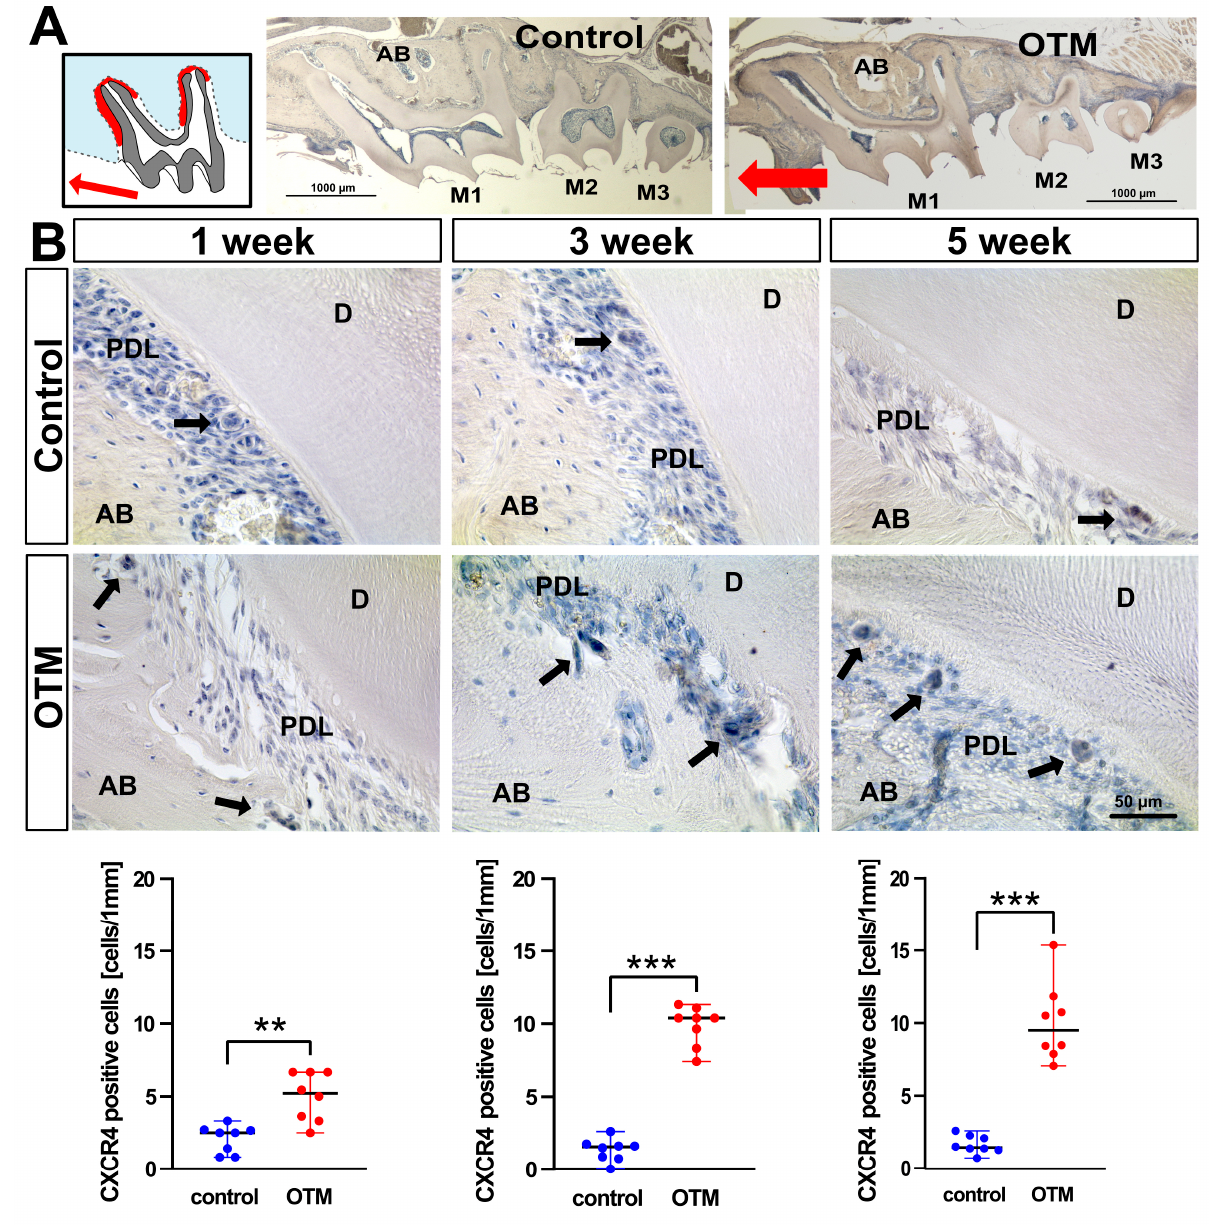
Figure 4. Increase in CXCR4-positive cells at the OTM side with NiTi coil spring compared to the untreated contralateral jaw side. ( A ) Schematic picture of compression zones in M1 distal roots (red) and overview pictures of sagittal sections of maxillary mice, contralateral control side and orthodontic tooth movement (OTM) side. ( B ) Focusing on the compression zones of M1 distal roots, a number of CXCR4-positive cells (black arrows) were counted on the OTM side and CC. On CC sides the baseline number of CRCR4-positive cells is not significantly different, while on the OTM side it exhibits a significant increase at all time points (** p < 0.01 and *** p < 0.001, respectively). Two micrographs of molars were randomly selected from at least two animals for histological analysis.